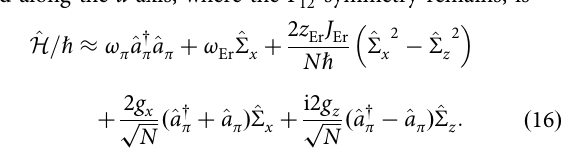
axis. The bold solid curves represent phase boundaries.